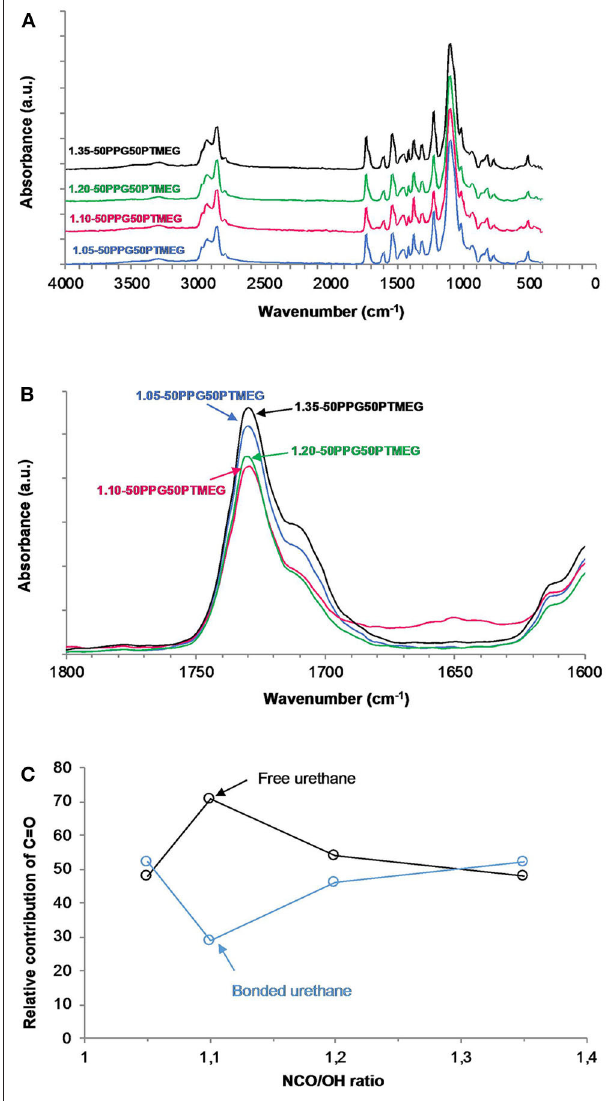
FIGURE 3 | (A) ATR-IR spectra, (B) carbonyl region (1,800–1,600 cm − 1 ) of the ATR-IR spectra, and (C) variation of the free and hydrogen-bonded urethane groups as a function of the NCO/OH ratio for TPUs synthesized with 50 wt% PPG + 50 wt% PTMEG blend and different NCO/OH